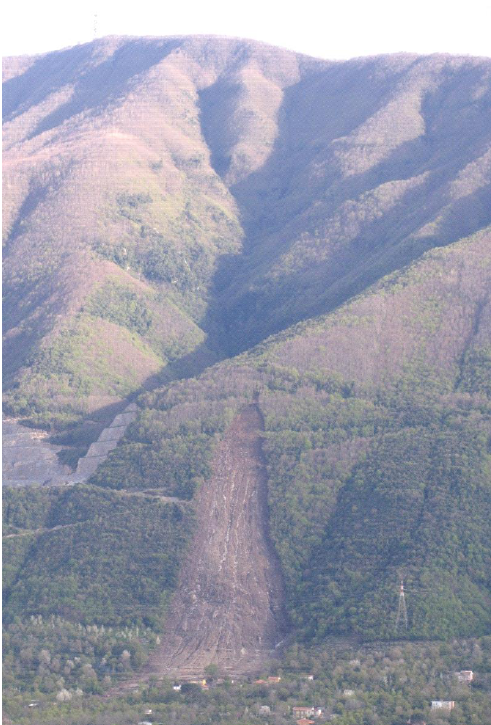
Figure 6. The Nocera Inferiore 2005 landslide area (Pagano et al., 2010,